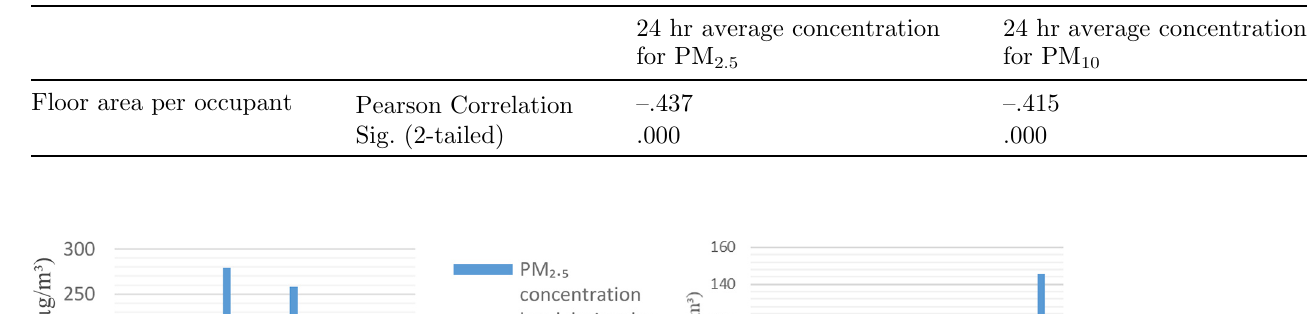
Table 7. Relationship between fl oor area per occupants and particulate matter concentrations.